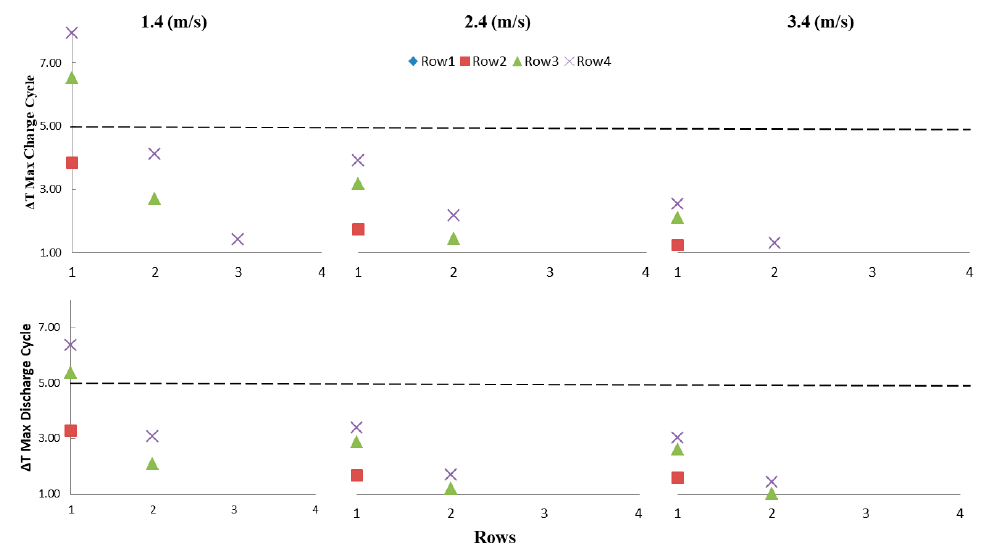
Figure 17. E ff ects of air flow rate on temperature di ff erences (0.5 C). Figure 17. Effects of air flow rate on temperature differences (0.5 C). Figure 17. Effects of air flow rate on temperature differences (0.5 C).